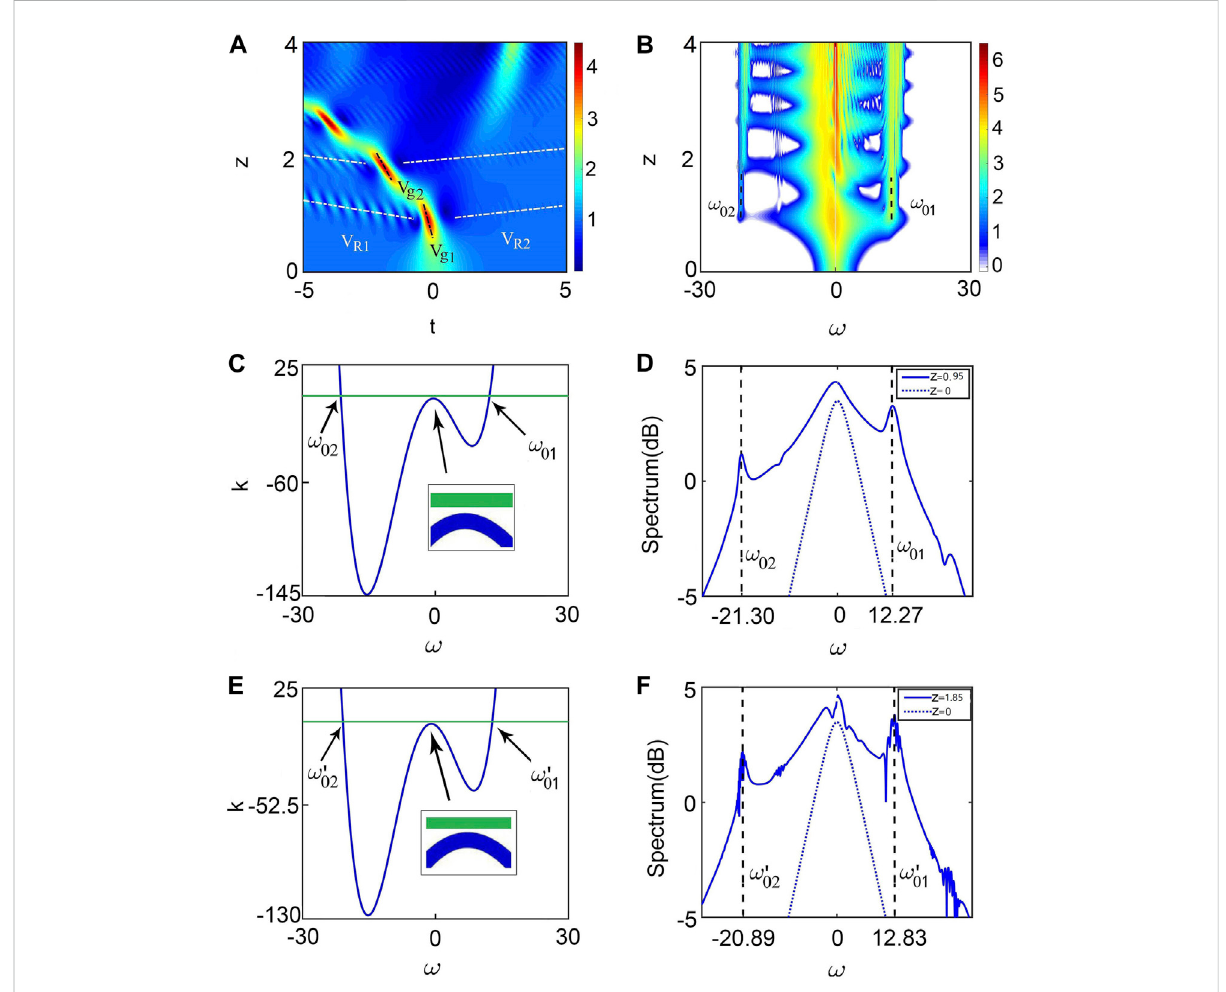
FIGURE 4 Radiation properties induced by the combined effects of TOD and FOD. (A,B) show false color plots of spatio-temporal evolution and spectra withtwo.In (A) ,thedashedblacklinesrefertogroupvelocitiesofthe fi rstandsecondcellofKMS, v g 1 = − 0.92033, v g 2 = − 2.Thedashedwhitelinesrefer to radiation velocities v R 1 = − 21.5271, v R 2 =58.0662. (C,D) Radiation frequencies and spectra for the fi rst cell of KMS with v g 1 . (C) Graphical solutions of Eq. 10. ω 01 and ω 02 are the intersection points corresponding to the radiation frequencies obtained exactly from the resonance condition. (D) Output spectrum in log scale (solid blue) compared with the input spectrum (dashed blue). (E,F) Similar to (C,D) but for the second cell of KMS with v g 2 . The parameters are β 3 =0.24, β 4 =0.096, and b =